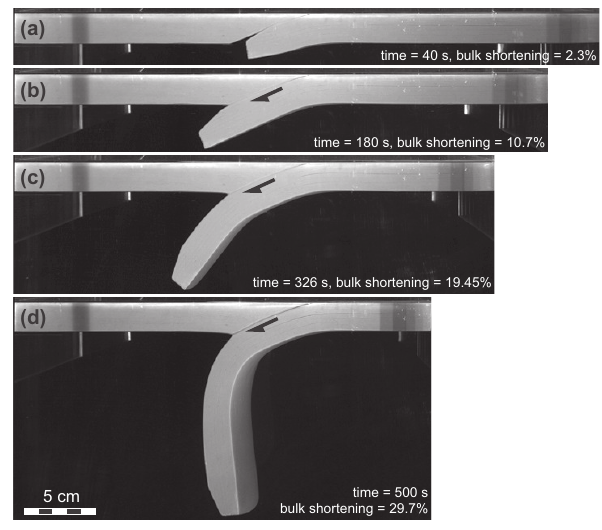
Fig. 7. Surface views of the model in Experiment 1. Correlation of successive images allows the derivation of a velocity field (arrows). Note that for clarity only 1 / 4 × 1 / 8 of all the velocity vectors are presented here. From the velocity field the normal strain in the convergence direction E xx is derived. The magnitude of E xx is calculated using the displacement field computed between 2 successive images taken 5 s apart (i.e. divide by 5 to obtain time-averaged strain rate). Both the vector field and the strain field reveal that the both plates are largely undeformed and convergence is accommodated by sliding of the lower plate under the upper plate.